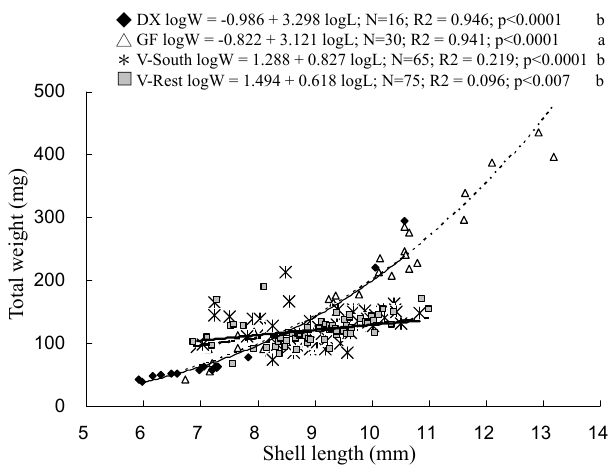
Figure 6. Relationship between shell length and total weight of Anachis and Euplica snails from different sites. Different letters fol- lowing the values in the legend indicate that the logarithmic trans- formed regression lines differ significantly ( p< 0 . 01).